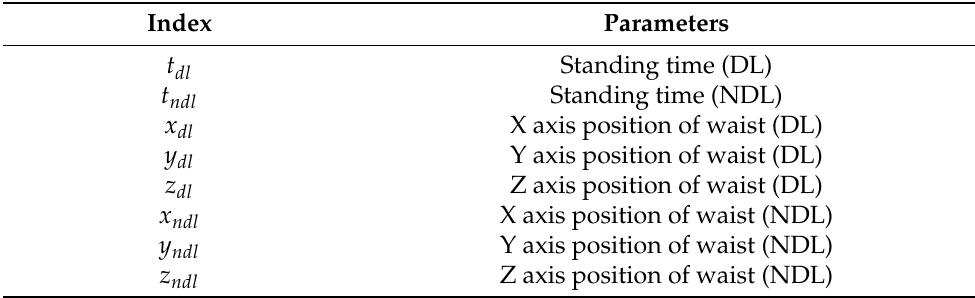
Figure 2. Experiment protocols followed during one-leg standing measurement. ( a ) One leg stance posture maintained along with the visual feedback given to the user. ( b ) Different stages of one-leg standing measurement. Table 3. Parameters considered for the one-leg standing measurement. The units for time and position-based parameters are second and meter, respectively. Abbreviations used in this table: Dominant Leg (DL); Non-Dominant Leg (NDL).